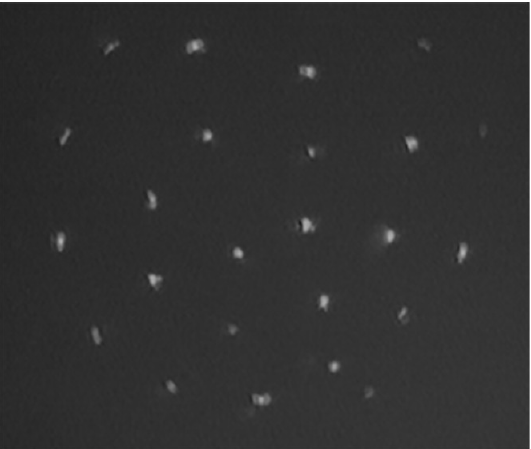
Figure 3. Horizontal section of a rotating dust structure in striation VI at h = 8.5 mm under conditions: p = 0.27 Torr, discharge current I = 1.5 mA, B = 390 G. The horizontal size of the frame is 2.4